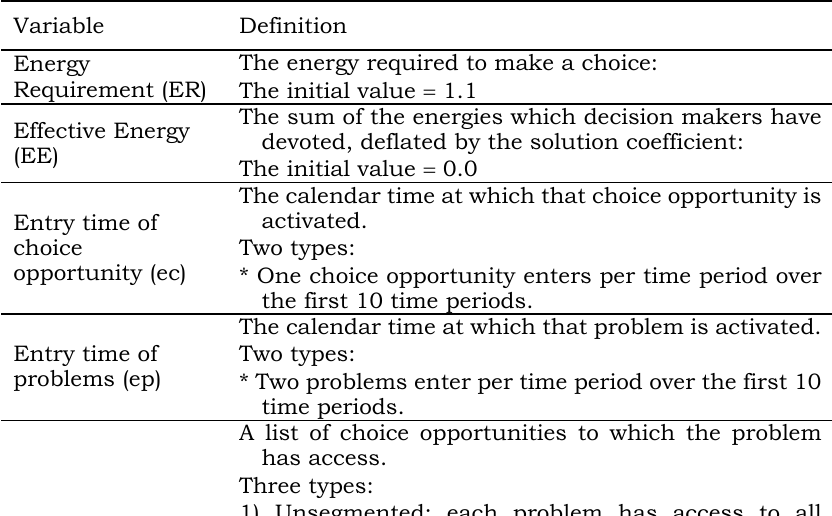
Table 1. The variables of the simulation model